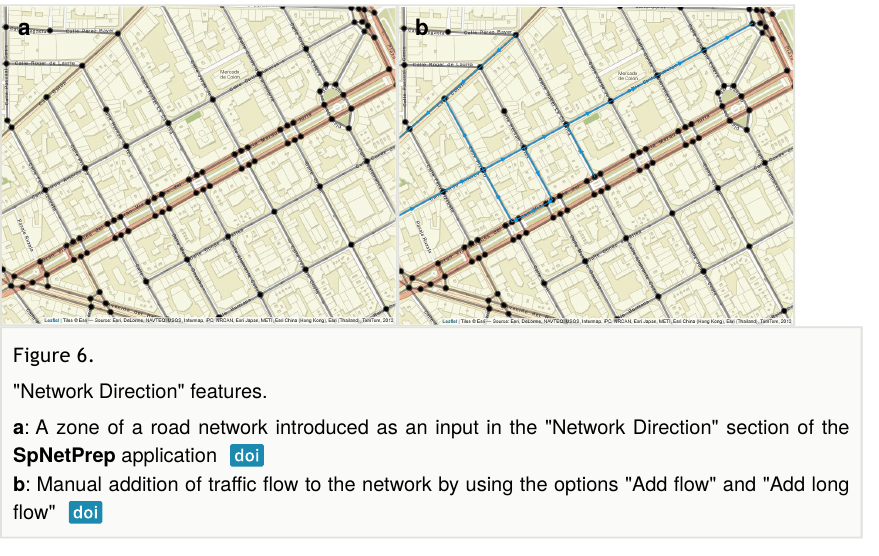
Figure 6. "Network Direction"